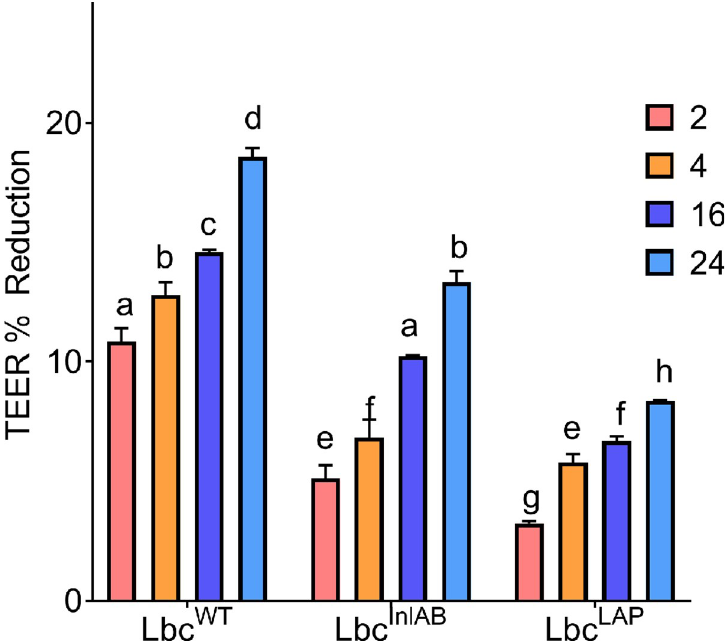
Fig 5. Caco-2 cell permeability analysis using transepithelial electrical resistance (TEER) in simulated intestinal conditions. TEER reduction by L . monocytogenes in the absence of L . casei strains was 20.5%. Bars marked with different letters (a, b, c, d, e, f, g, h) indicate significant difference at p < 0.05, error bars are standard deviations of average TEER reductions of the three independent experiments.